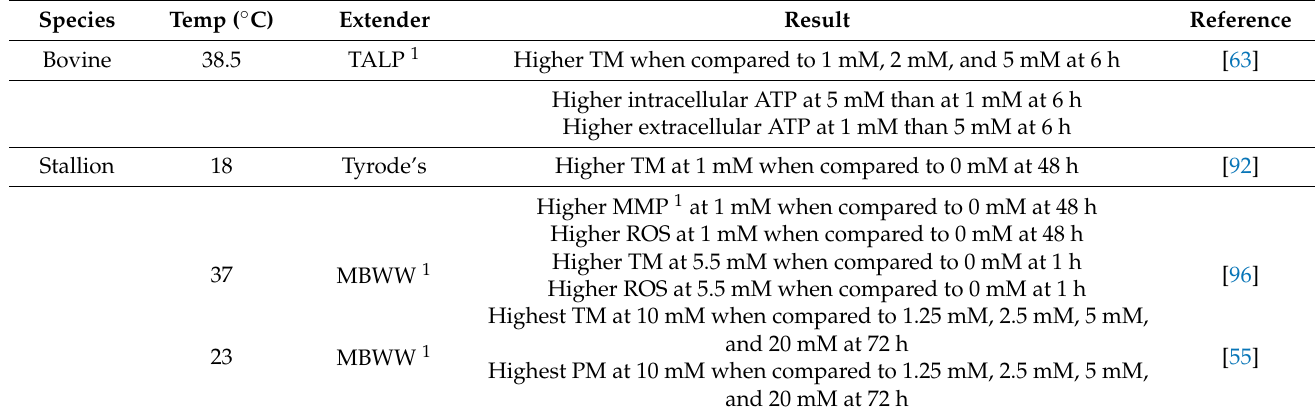
Table 5. Summary of noteworthy results on pyruvate supplementation to semen storage above 5 ◦ C in various